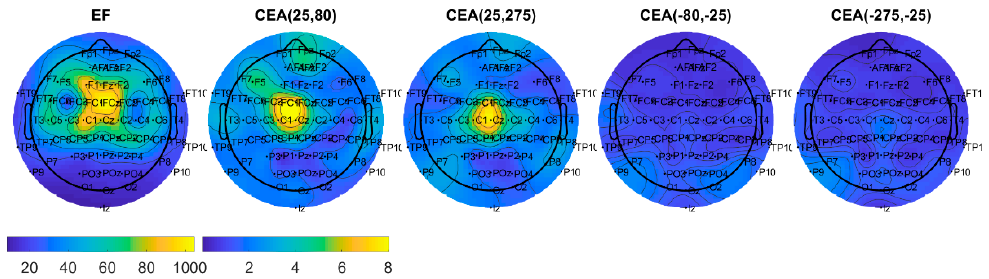
Figure 4. Topographic plots for the average across all subjects E-field, and CEA(25,80) and CEA(25,275), as well as indicative CEA values for two pre-TMS windows.